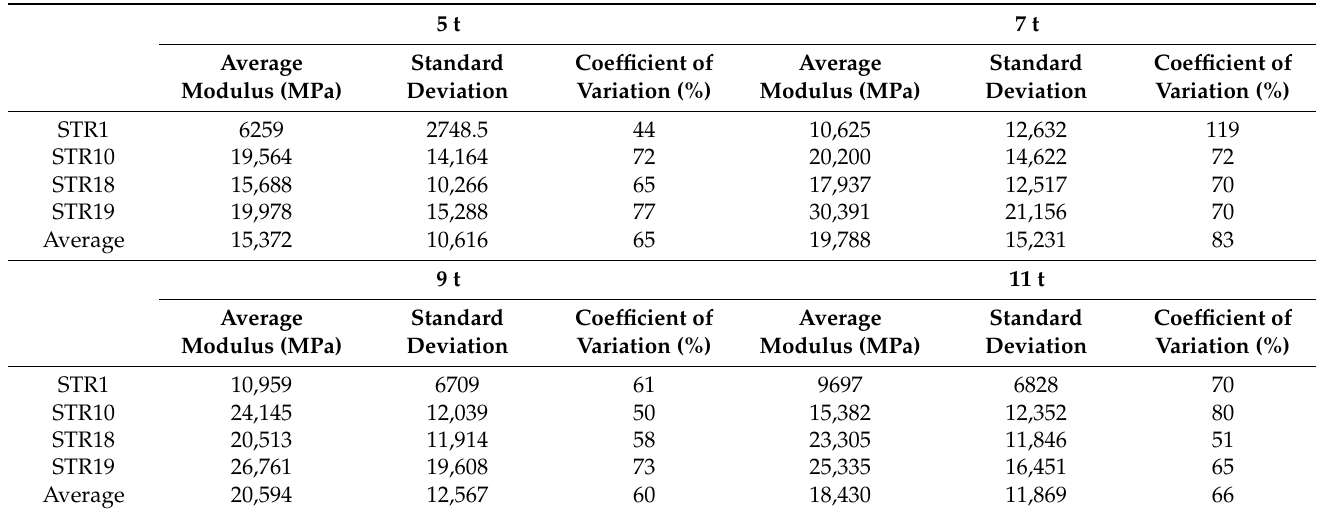
Table 8. The modulus back calculation results of asphalt concrete surface layer.